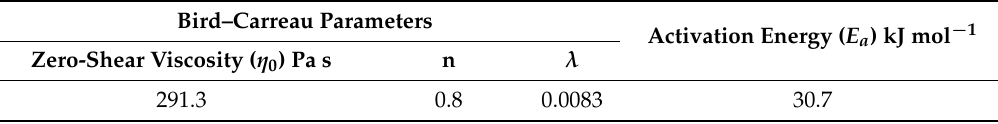
Table 2. The Bird–Carreau parameters and activation energy value used in the viscosity model of PCL at a T ref of 100 ◦